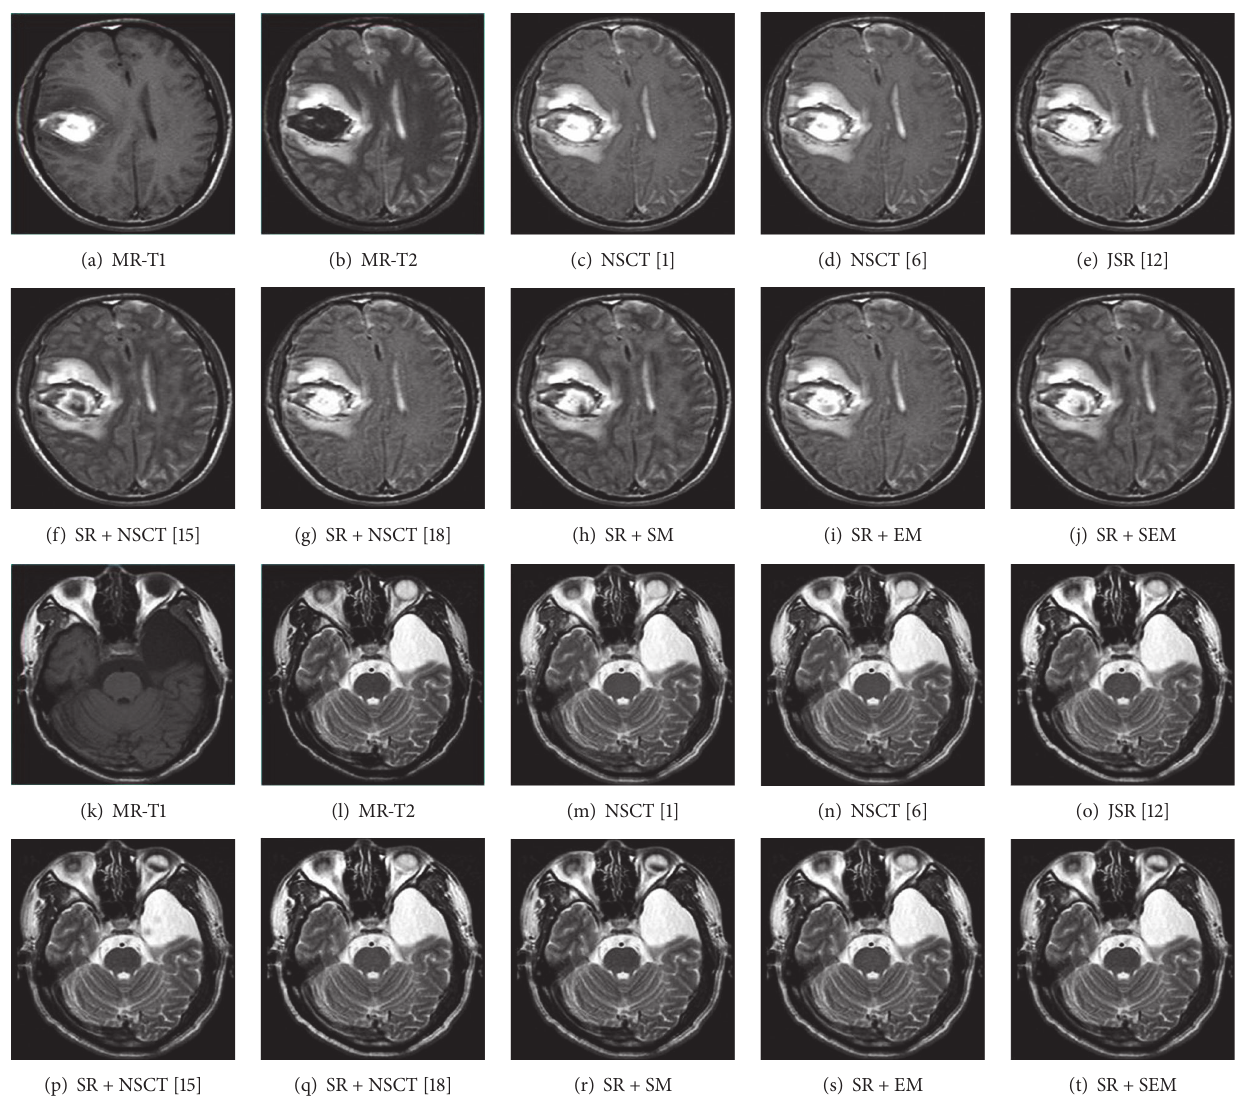
Figure 6: The MR-T1 and MR-T2 image fused results of different fusion methods.